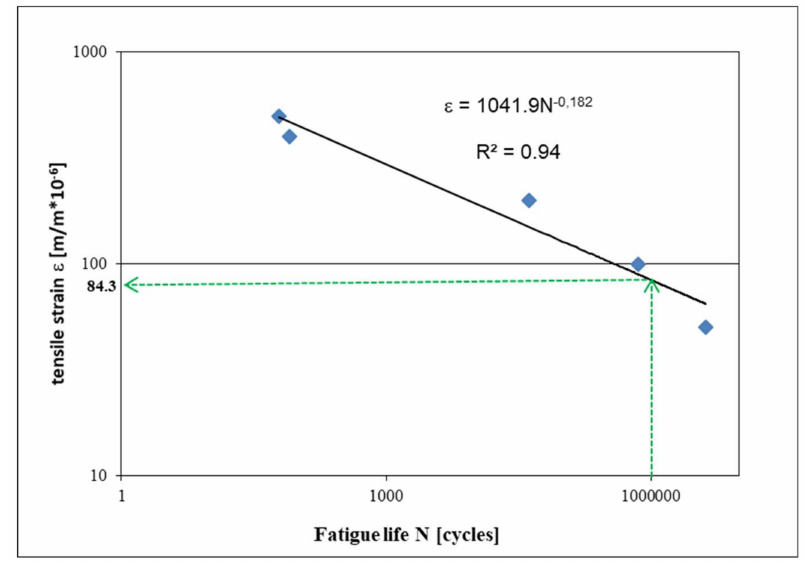
Figure 5. FAC mixture fatigue curve—permanent deformation